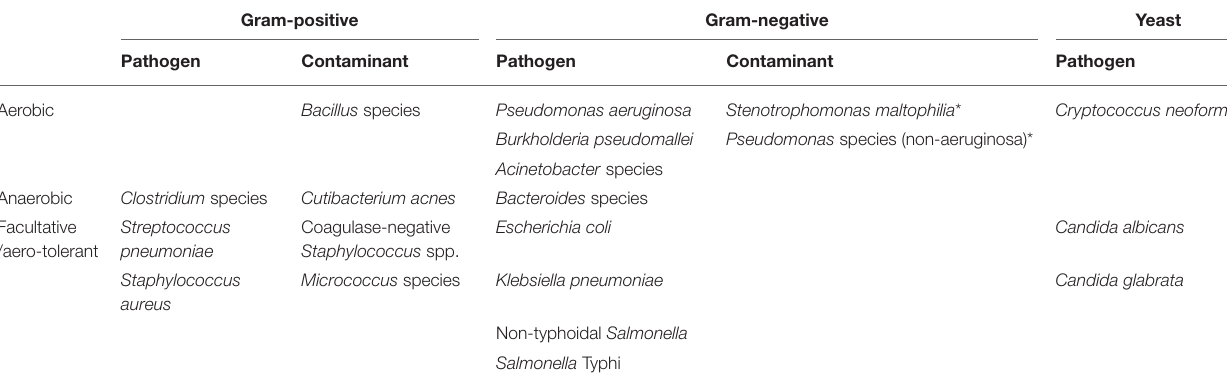
TABLE 1 | Examples of common bacterial species grown in blood